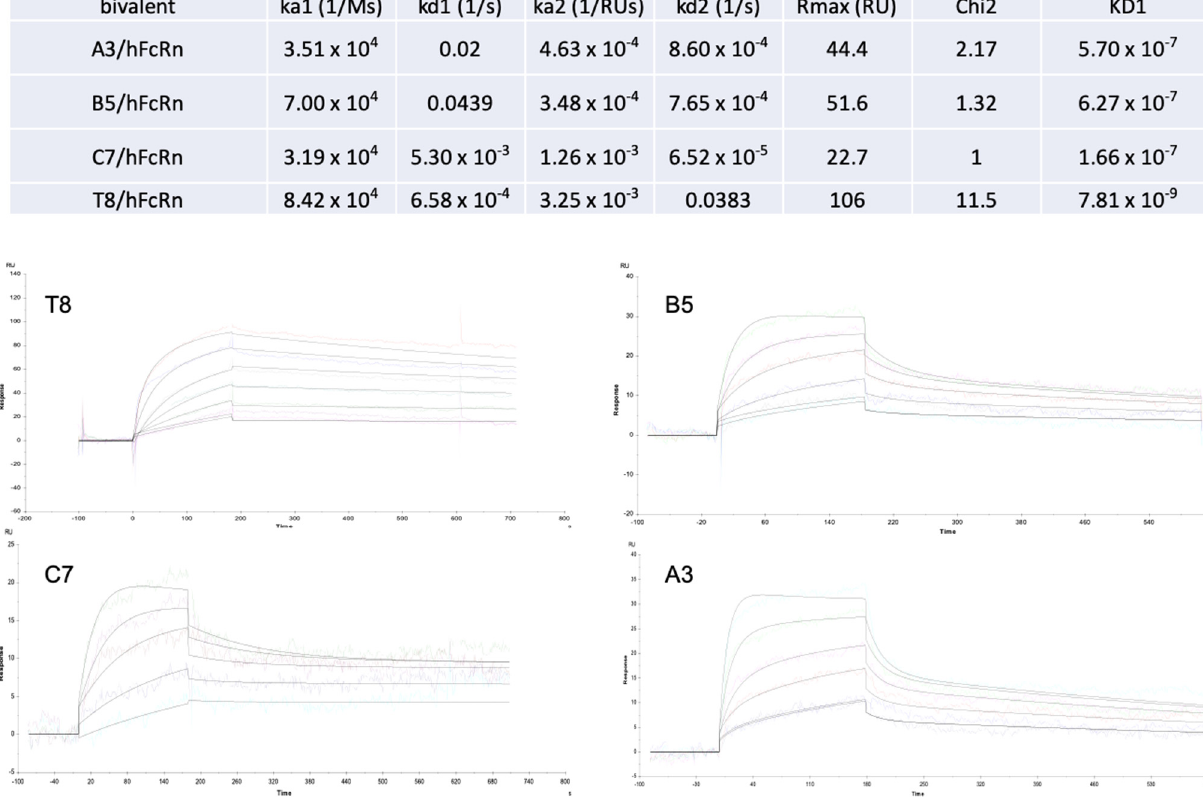
Figure A2. SPR experiments’ bivalent fit for variants A3, B5, C7, and T8.